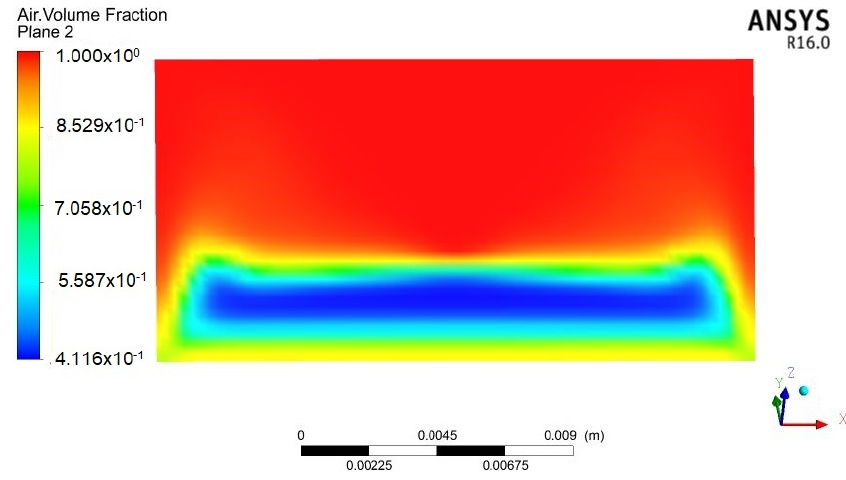
Figure 4. Air volume fraction at plane 2.